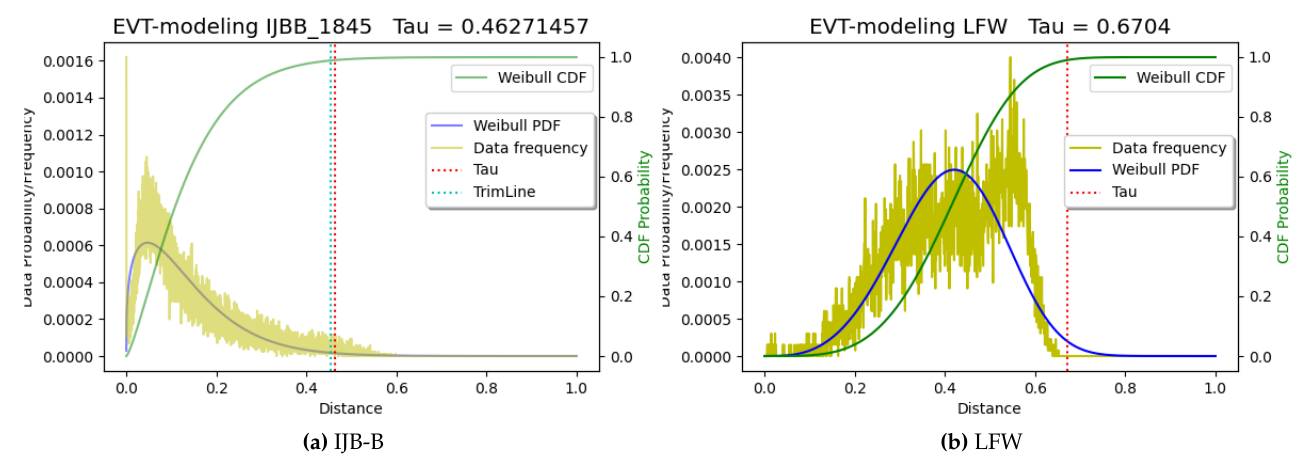
Figure 2. Weibull Modeling. The distribution of ANN distances is proven Weibull. ( a ) shows the histogram of distances from IJB-B dataset, the resulting Weibull fit, its CDF, and the resulting τ w . ( b ) shows the plot for LFW data, which is impacted from outliers and mode shift is used as one heuristic for outlier detection. Note that there are ANN distances above τ w , which would be rejected as outliers and not